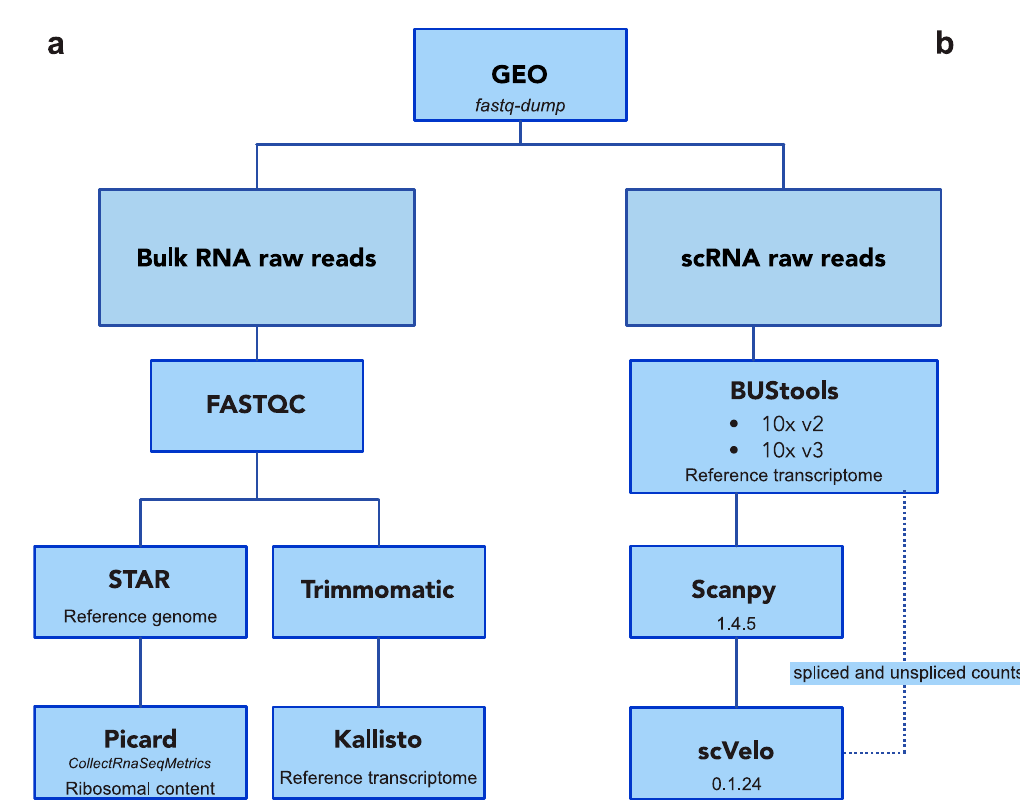
Figure A5. Bioinformatic pipeline for bulk and single-cell RNA-seq. Schematic view of the pipelines to process raw reads from both bulk and scRNA seq datasets. Table A1. Gene markers used for overlapping annotation in organoids. This table shows the markers gathered from the literature to annotate the scRNA-seq clusters according to the higher retinal cell- type score.